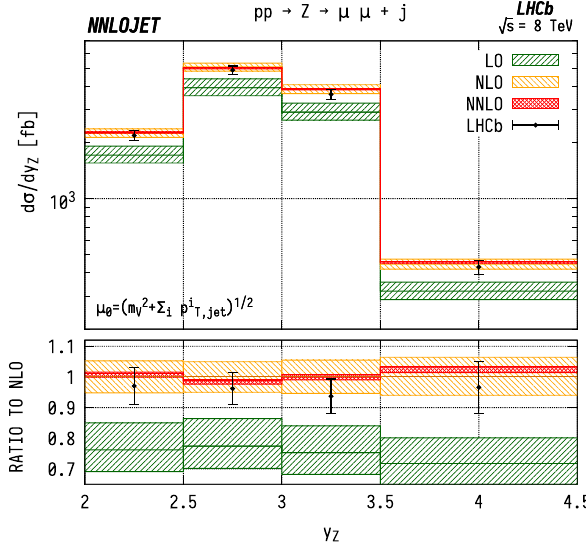
Fig. 11 Cross section differential in the rapidity of the dilepton system for ZJ production. See Fig. 3 for details